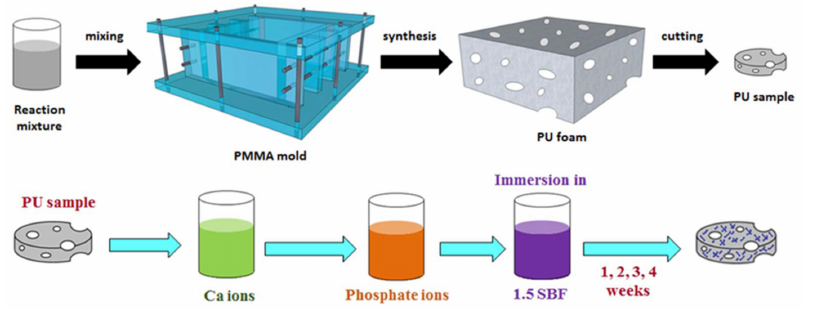
Figure 7. Schematic diagram of polyurethane foam/nano-hydroxyapatite composite fabrication. Reprinted from [57] with permission from